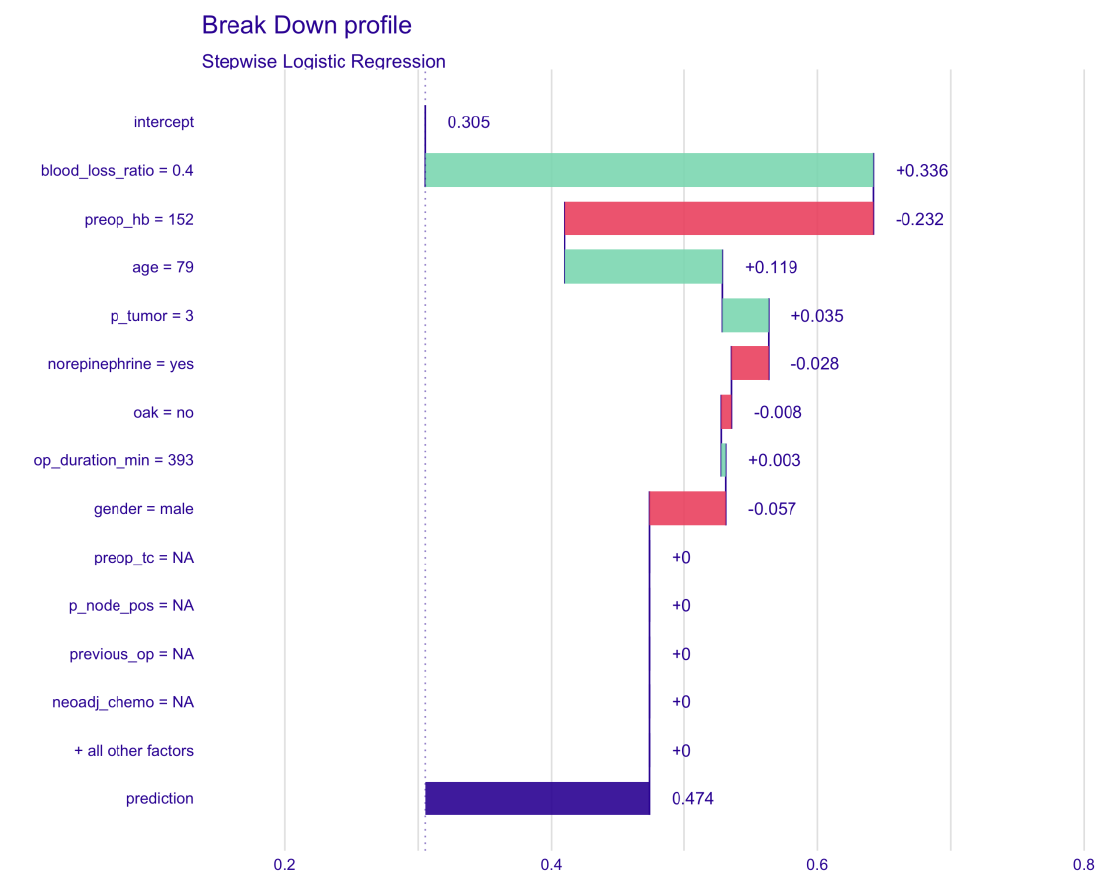
Figure A8. Older male patient with higher hemoglobin levels and higher blood loss (p trans = 47.4%).